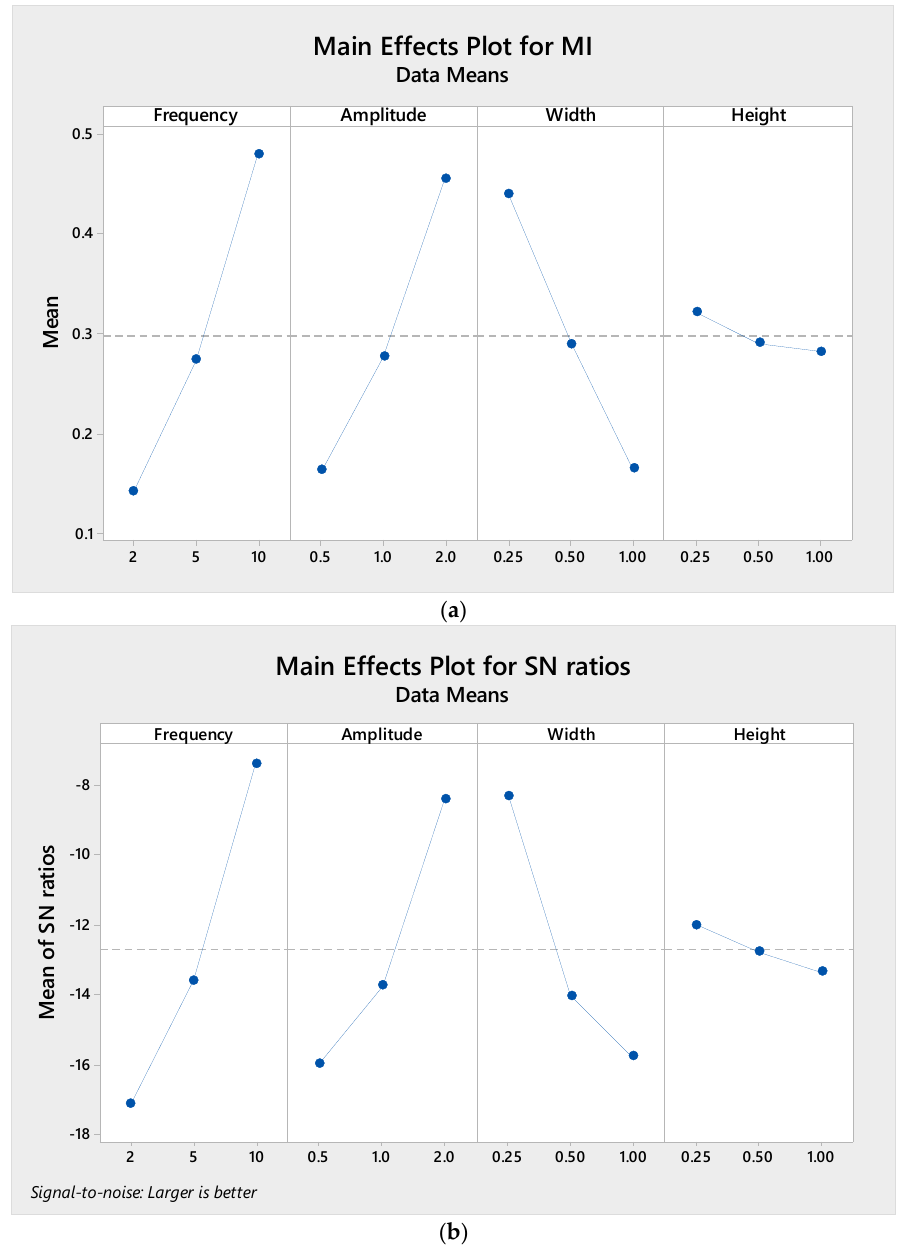
Figure 3. Taguchi results of ( a ) Mean and ( b ) signal-to-noise (S/N) response graph for mixing performance.